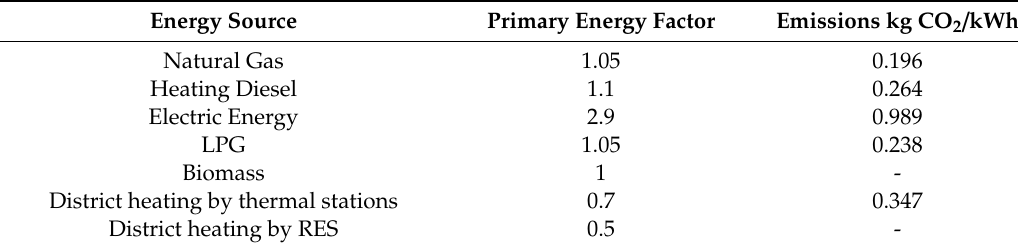
Table 1. Primary energy